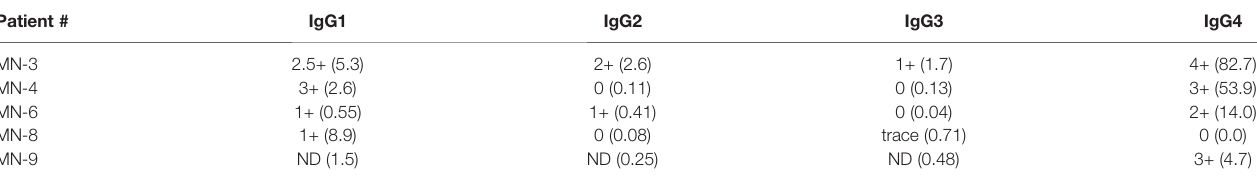
The values represent the intensity of IF staining (serum anti-THSD7A IgG subclass level in m